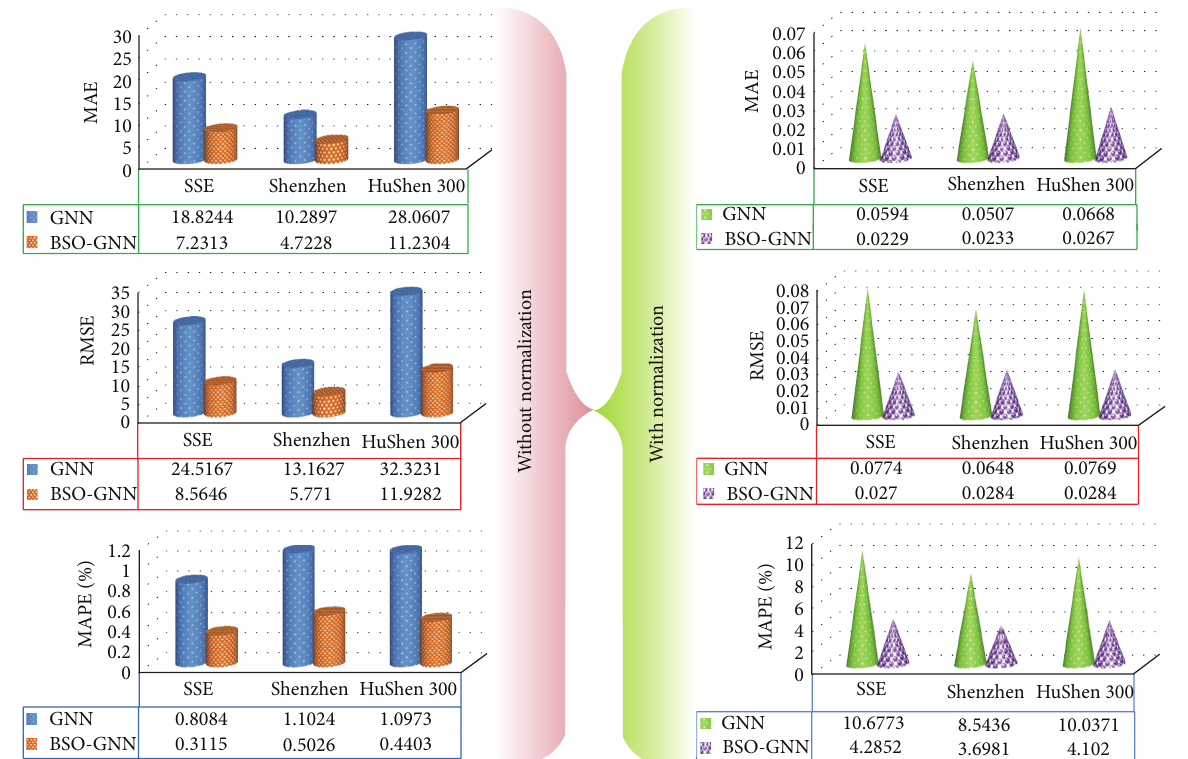
Figure 7: Forecasting errors of the GNN and BSO-GNN models under different data preprocessing